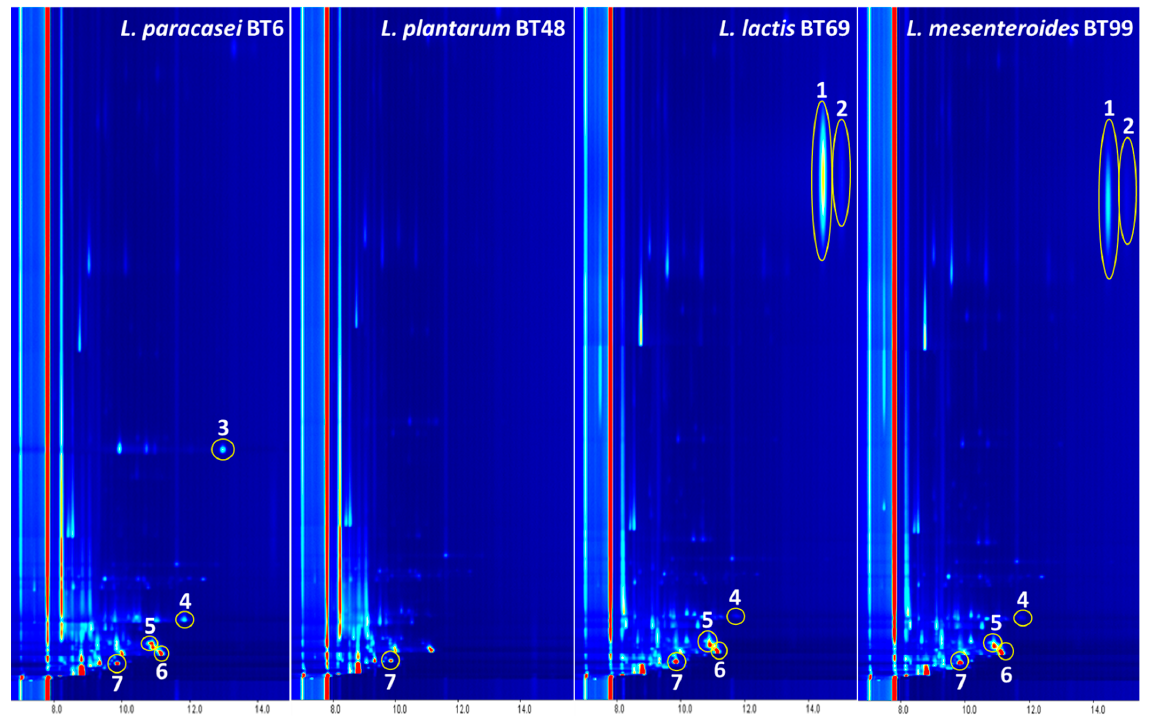
Figure 1. VOCs detected in LAB MRS cultures by GC–IMS. VOCs highlighted: (1) 2-heptanol; (2) 3-hydroxybutan-2-one; (3) 2-heptanone; (4) 3-methyl-1-butanol; (5) 2-butanol; (6) 2-pentanone; (7) 2-butanone.